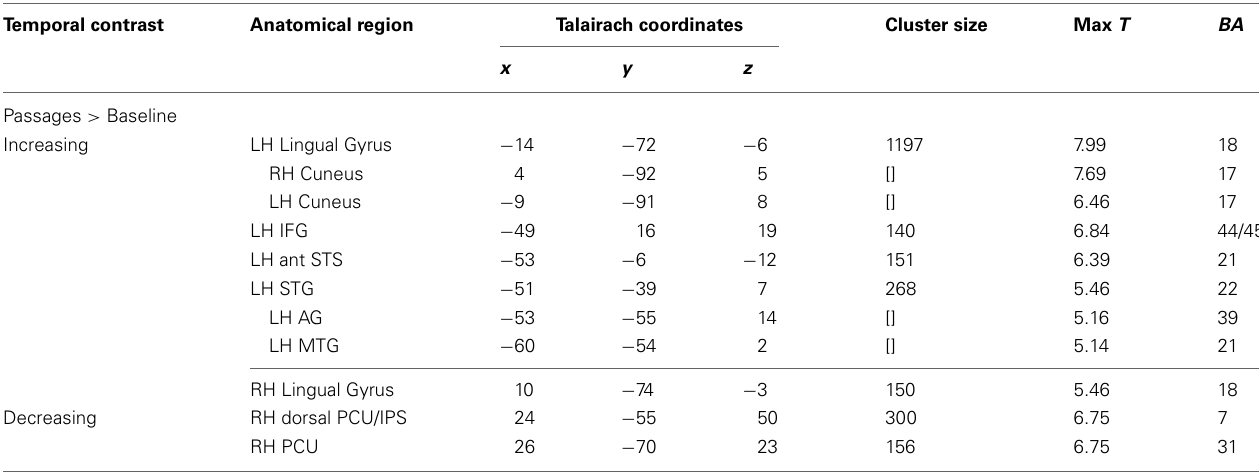
Table 3 | Passages vs. Baseline temporal